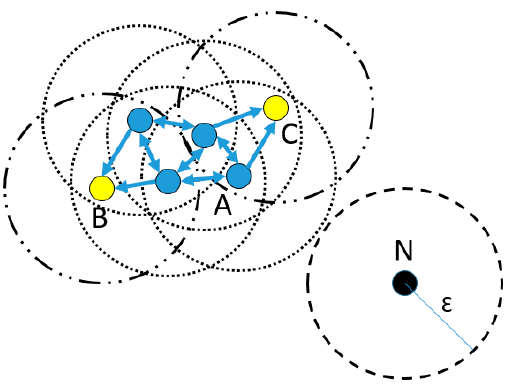
Figure 2. Groups formed in the application of the DBSCAN algorithm with Min. Points = 4.